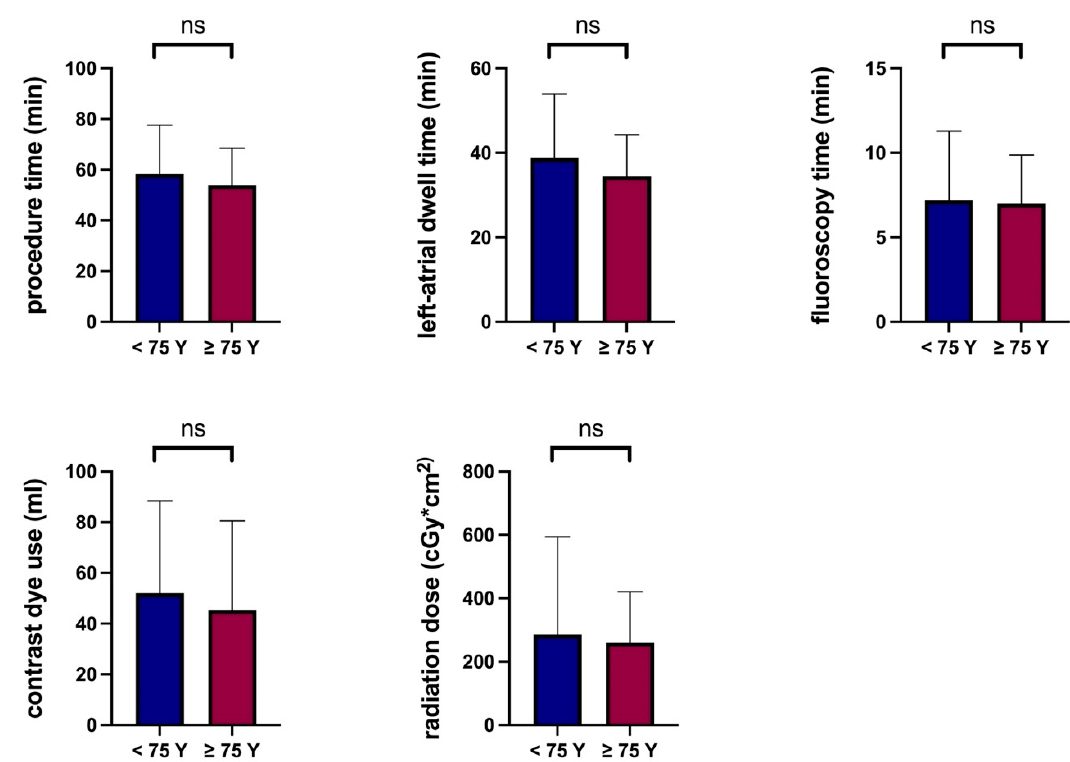
Figure 2. Comparison of procedural parameters between patients <75 and ≥ 75 years of age. Y, years; ns, not significant.